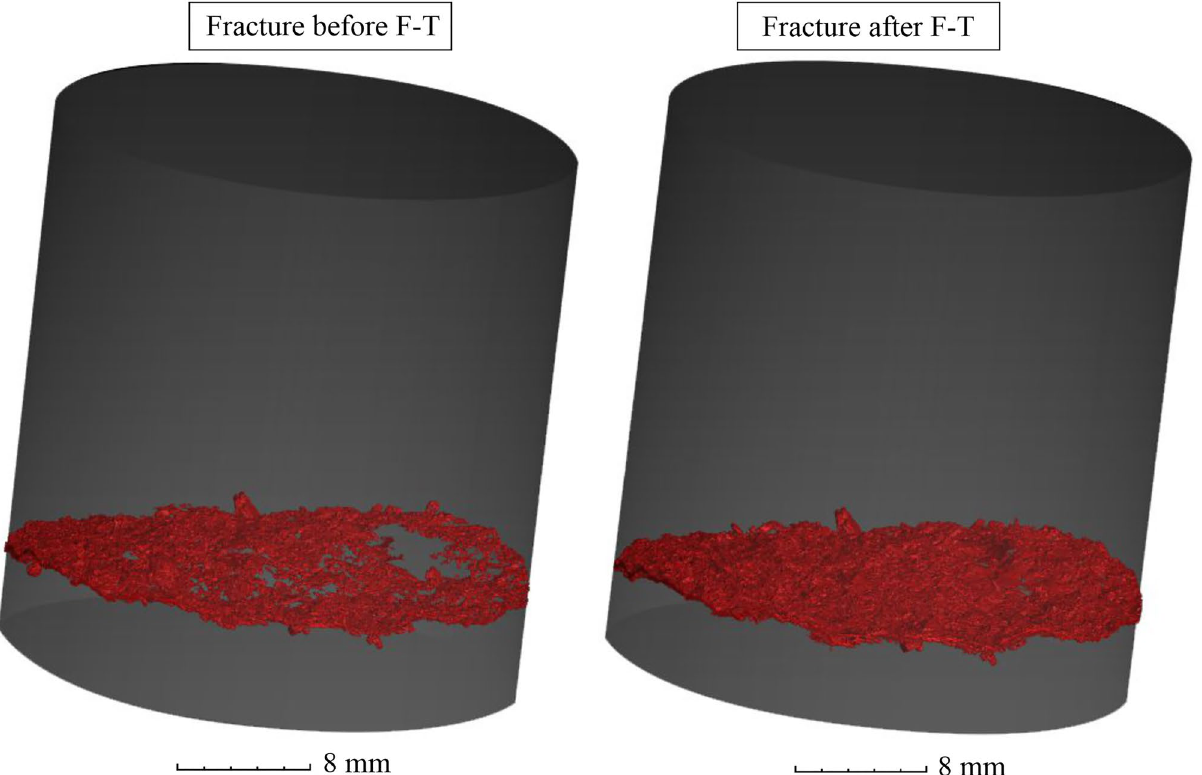
Figure 8. Visualization showing detail of transversal fracture and its volume increase after 100 F–T cycles by 31.44